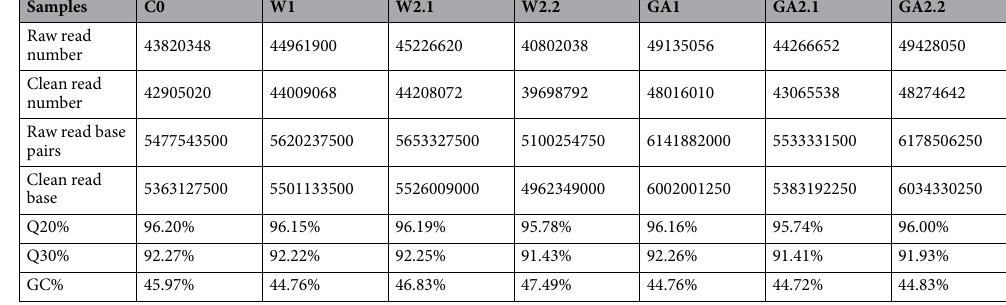
Table 1. Overview of the sequencing reads. Q20: The percentage of bases with quality value larger than 20. Q30: The percentage of bases with quality value larger than 30. GC%: The percentage of proportion of guanidine and cytosine nucleotides among total nucleotides.